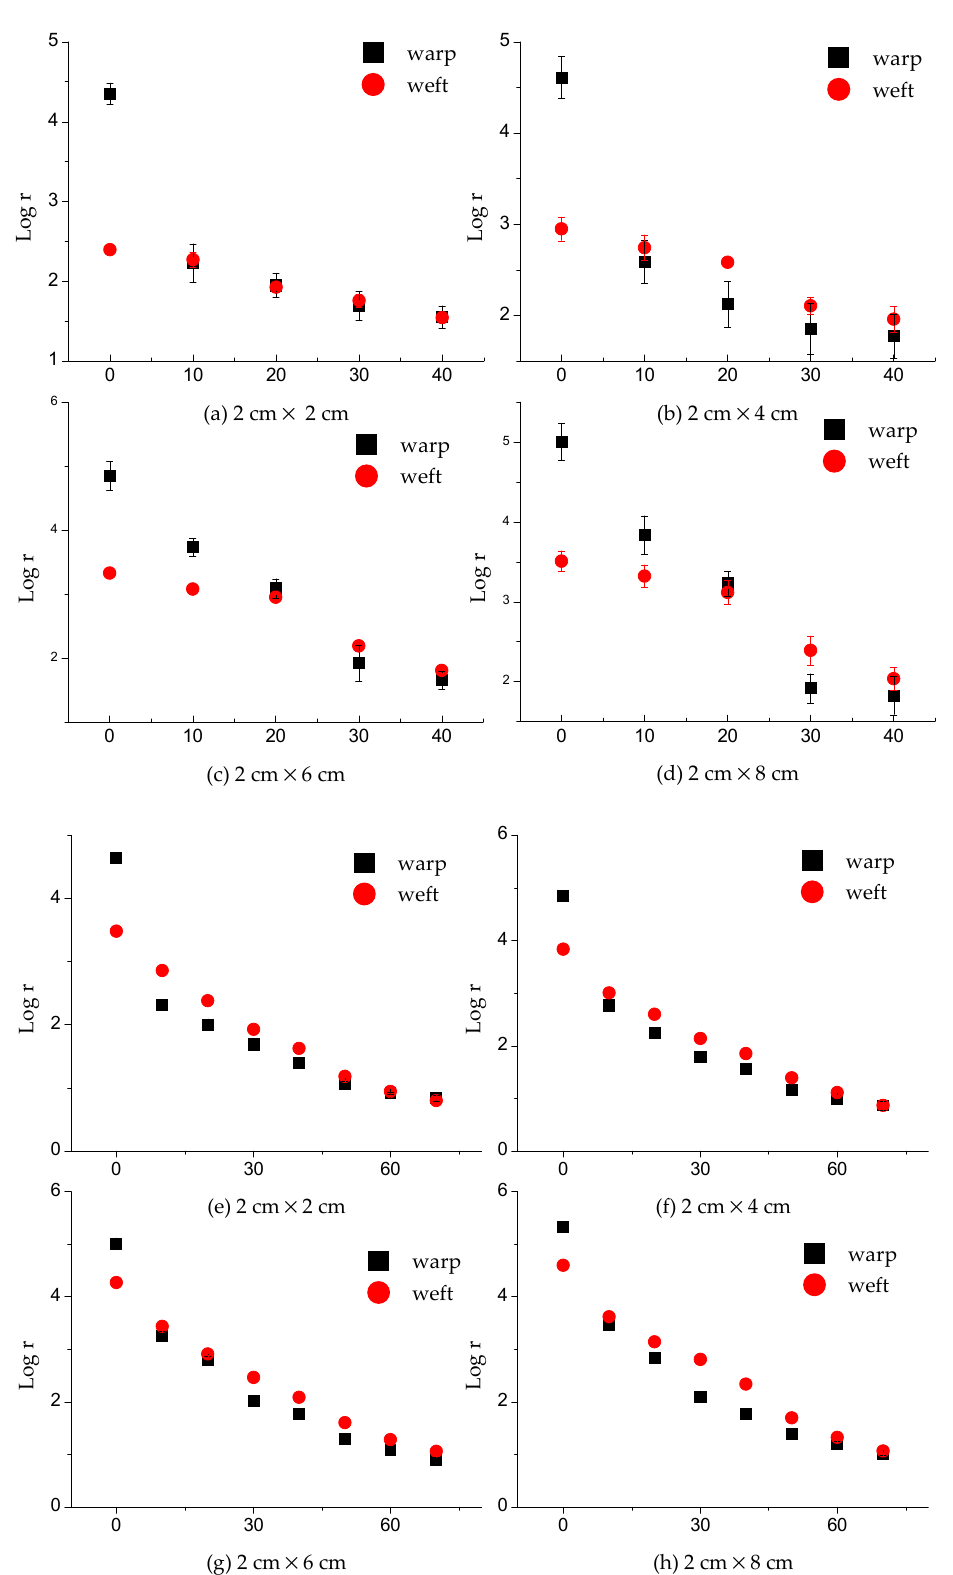
Figure 9. The comparison of log r of warp and weft directions. For treated fabric, under dry conditions, the values in the warp direction were higher than that in the weft direction, but under wet conditions, it was the inverse.